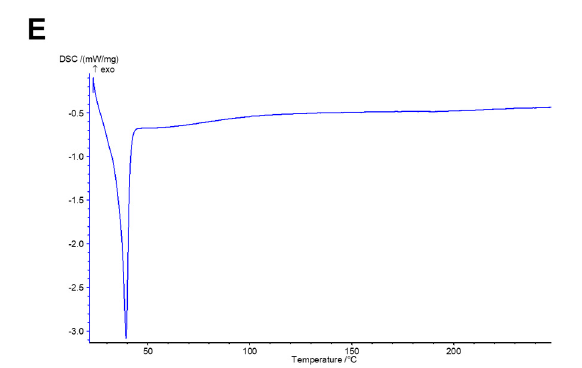
Figure 5. DSC thermograms of ( A ) R19, ( B ) neat TPGS, and R19-loaded NPs composed of ( C ) 100% TPGS, ( D ) 25% P123/75% TPGS, and ( E ) 50% P123/50% TPGS.